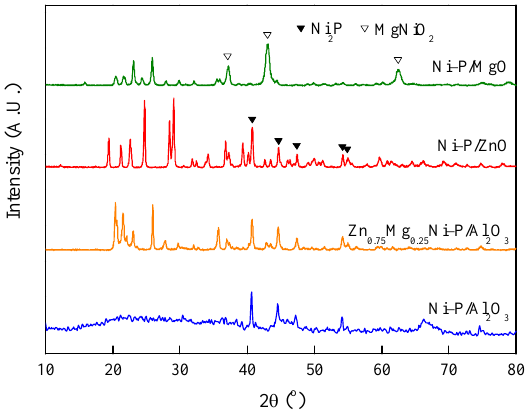
Figure 5. The XRD patterns of different nickel phosphate catalysts.